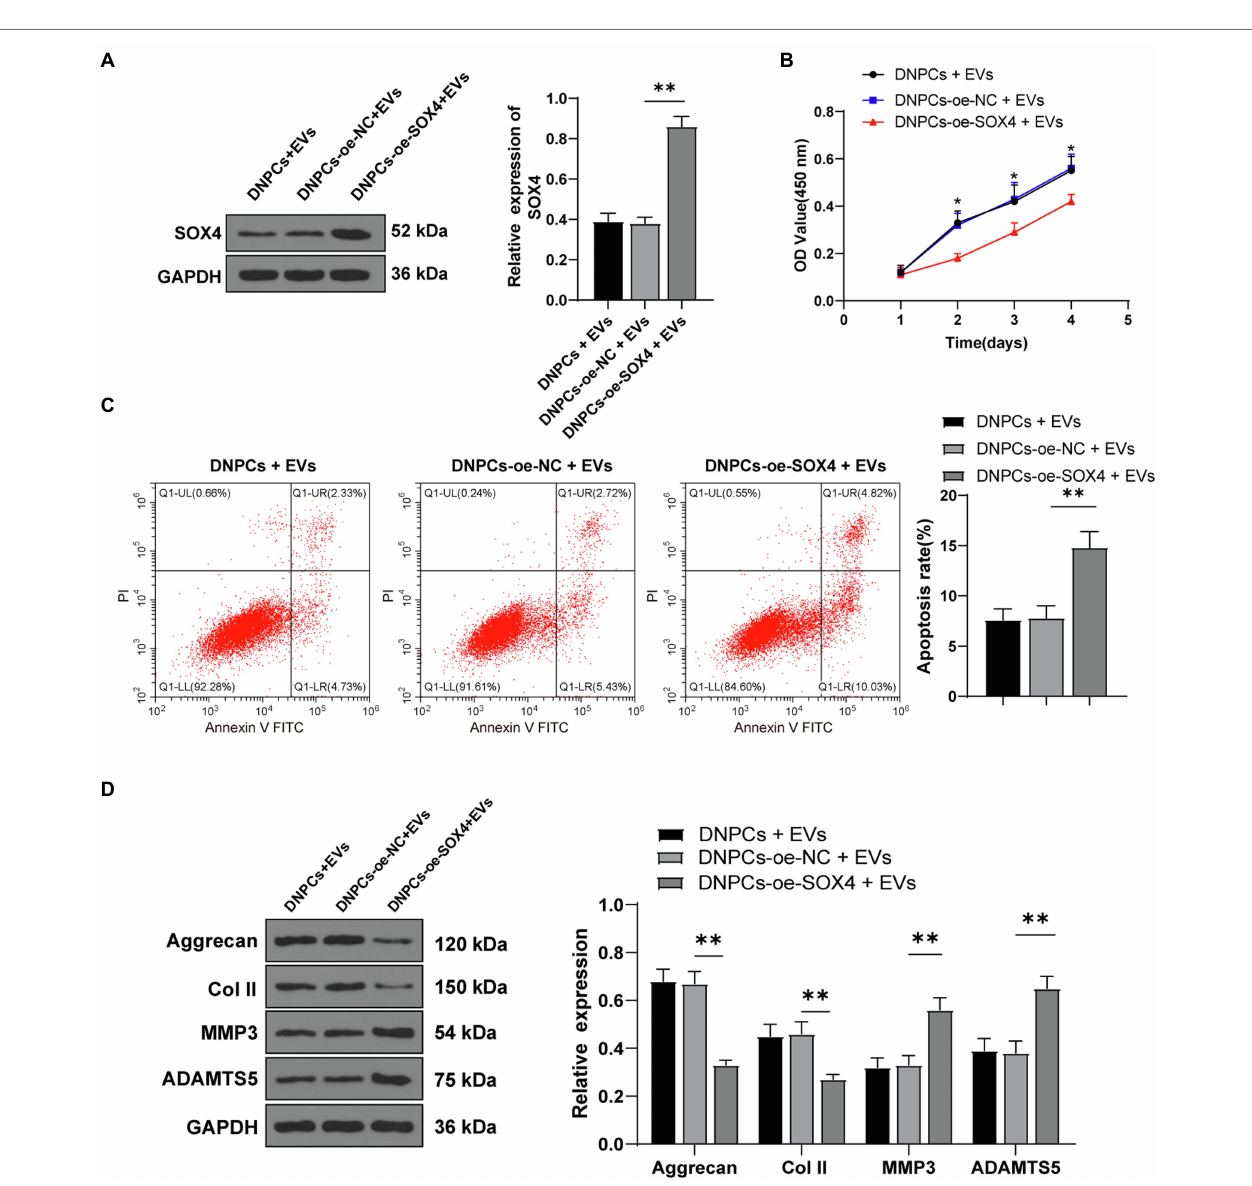
FIGURE 6 | SRY-box transcription factor 4 overexpression partially inverted the promoting effect of EVs on DNPCs proliferation and ECM synthesis. (A) SOX4 expression in DNPCs detected by Western blot; (B) DNPCs proliferation detected by CCK-8 assay; (C) DNPCs apoptosis detected by flow cytometry; (D) expressions of ECM synthetic genes Aggrecan and Col II and ECM degrading genes MMP3 and ADAMTS5 detected by Western blot. Cell experiment was repeated three times. Data were presented as mean ± standard error. Comparisons among groups were analyzed using one-way ANOVA, followed by Tukey’s multiple comparisons test. * p < 0.05, ** p <